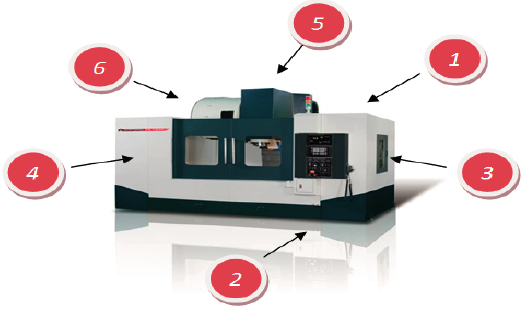
Figure 2. The main parts of the body